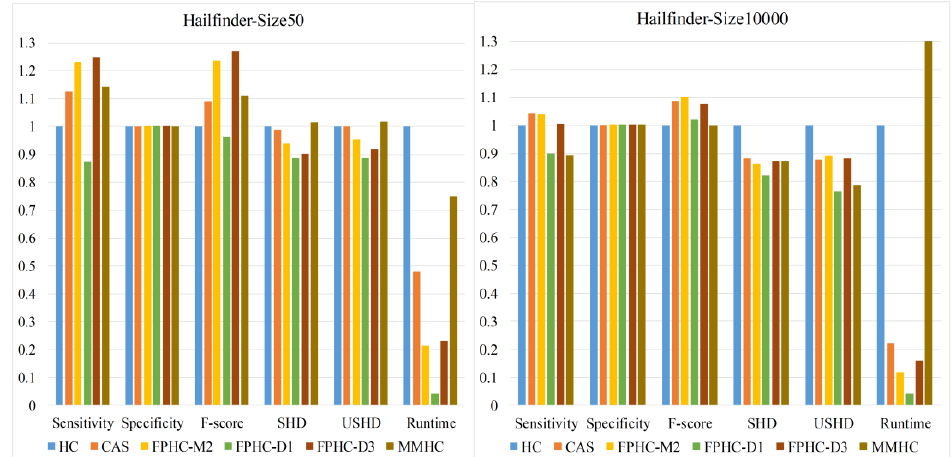
Figure 6. The performance comparison of different methods when sample size is 50 and 10,000.